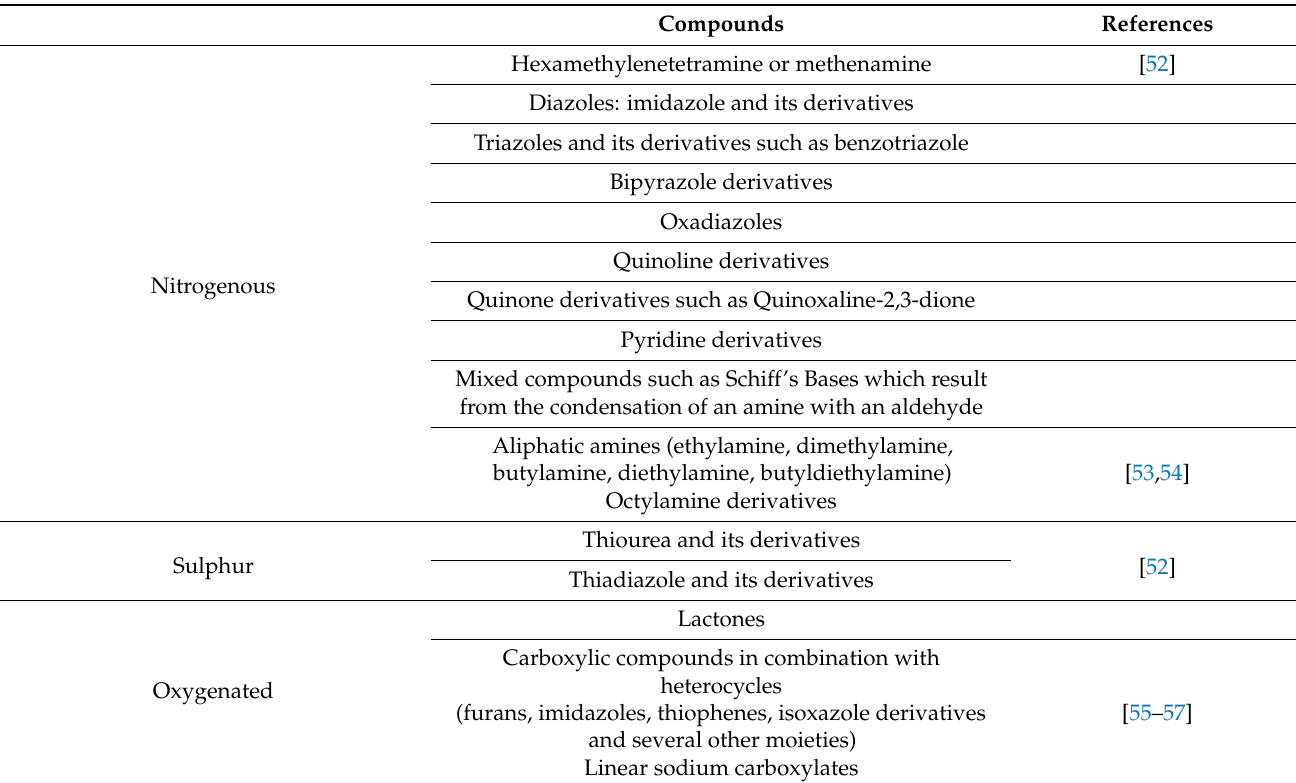
Table 2. Examples of inhibitors used for the protection of iron and its alloys in acidic media.